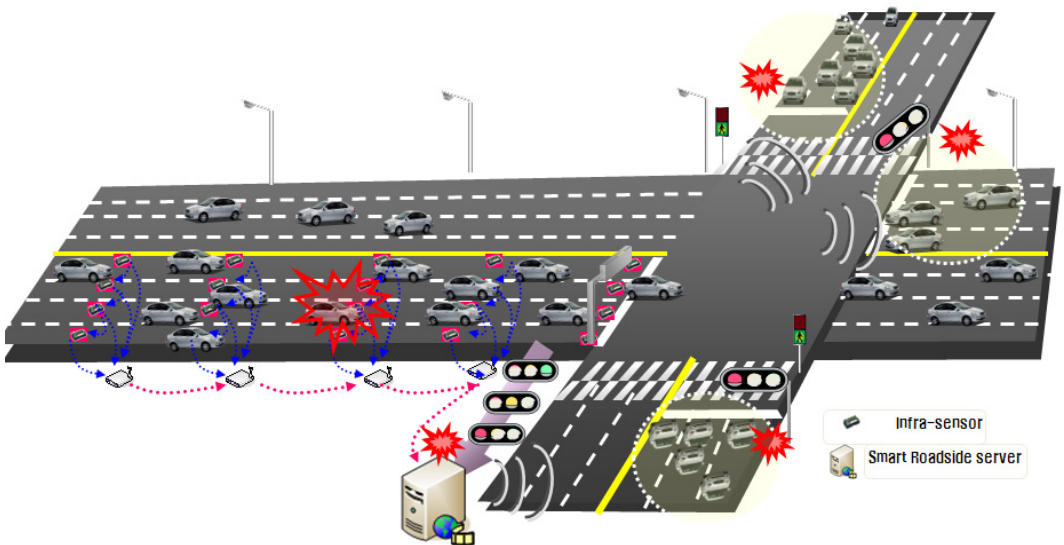
Figure 5. Red-light violation warning system at a signalized